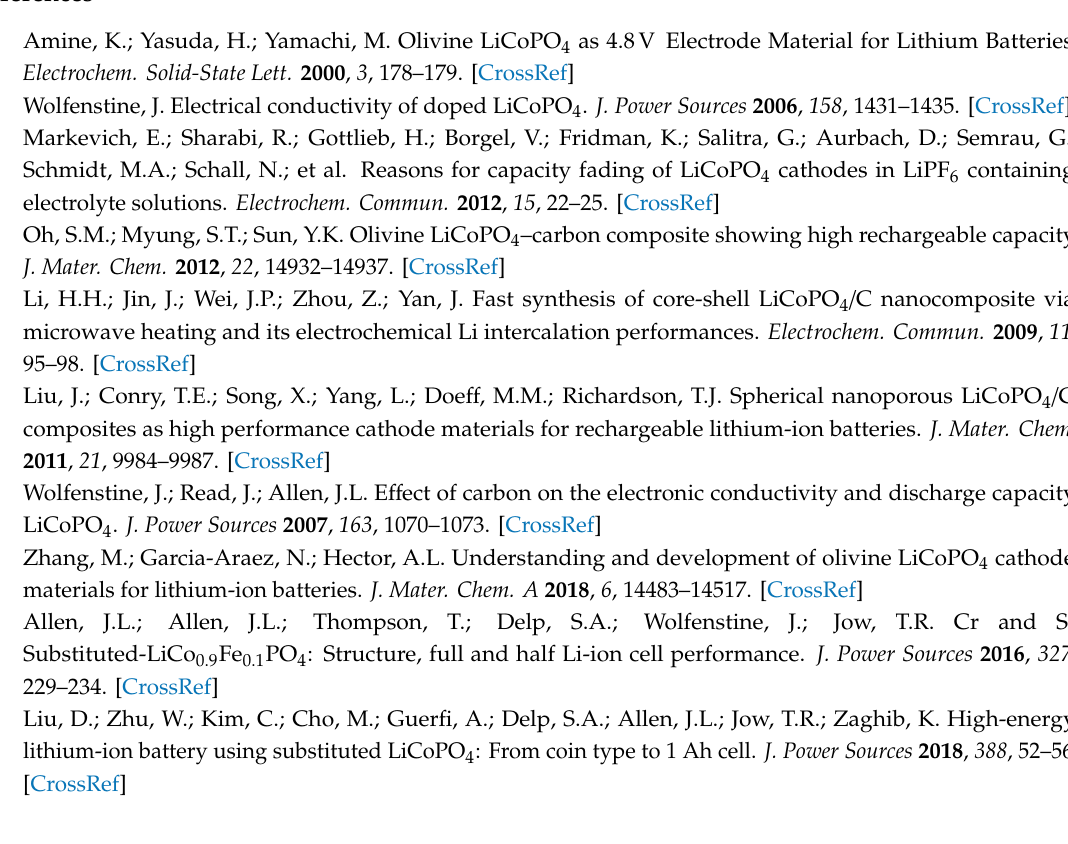
Figure S1: (a) 1.2 Ah LCP pouch cell using EC-EMC commercial electrolyte after cycling at 25 ◦ C. (b) 1.2 Ah LCP pouch cell using Py 13 FSI ionic liquid electrolyte after cycling at 25 ◦ C. Figure S2: Image of the 1.2 Ah LCP pouch cell before (a) and after (b) the hot box test, number 1–6 in S2 (a) corresponding to the thermal couples in the